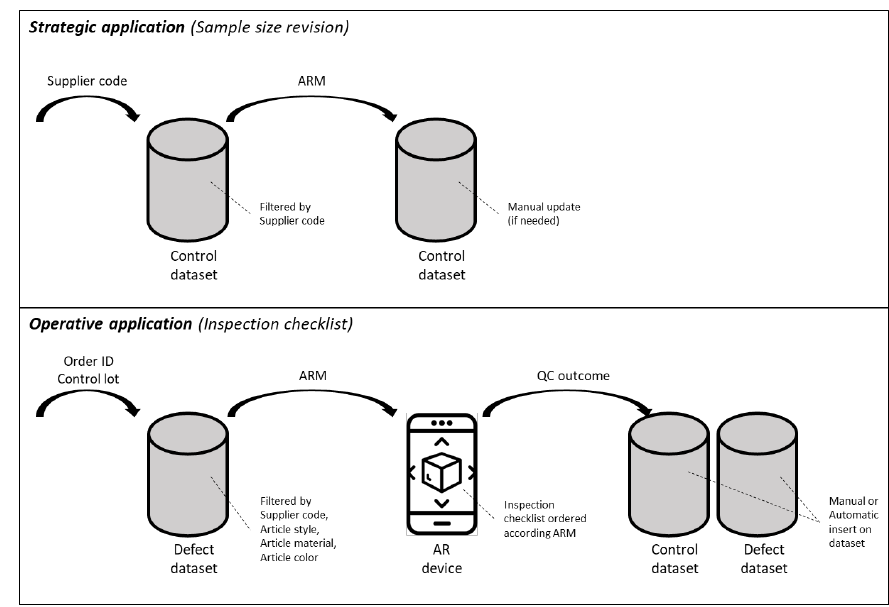
Figure 2. Information flow for the framework strategic and operative application .